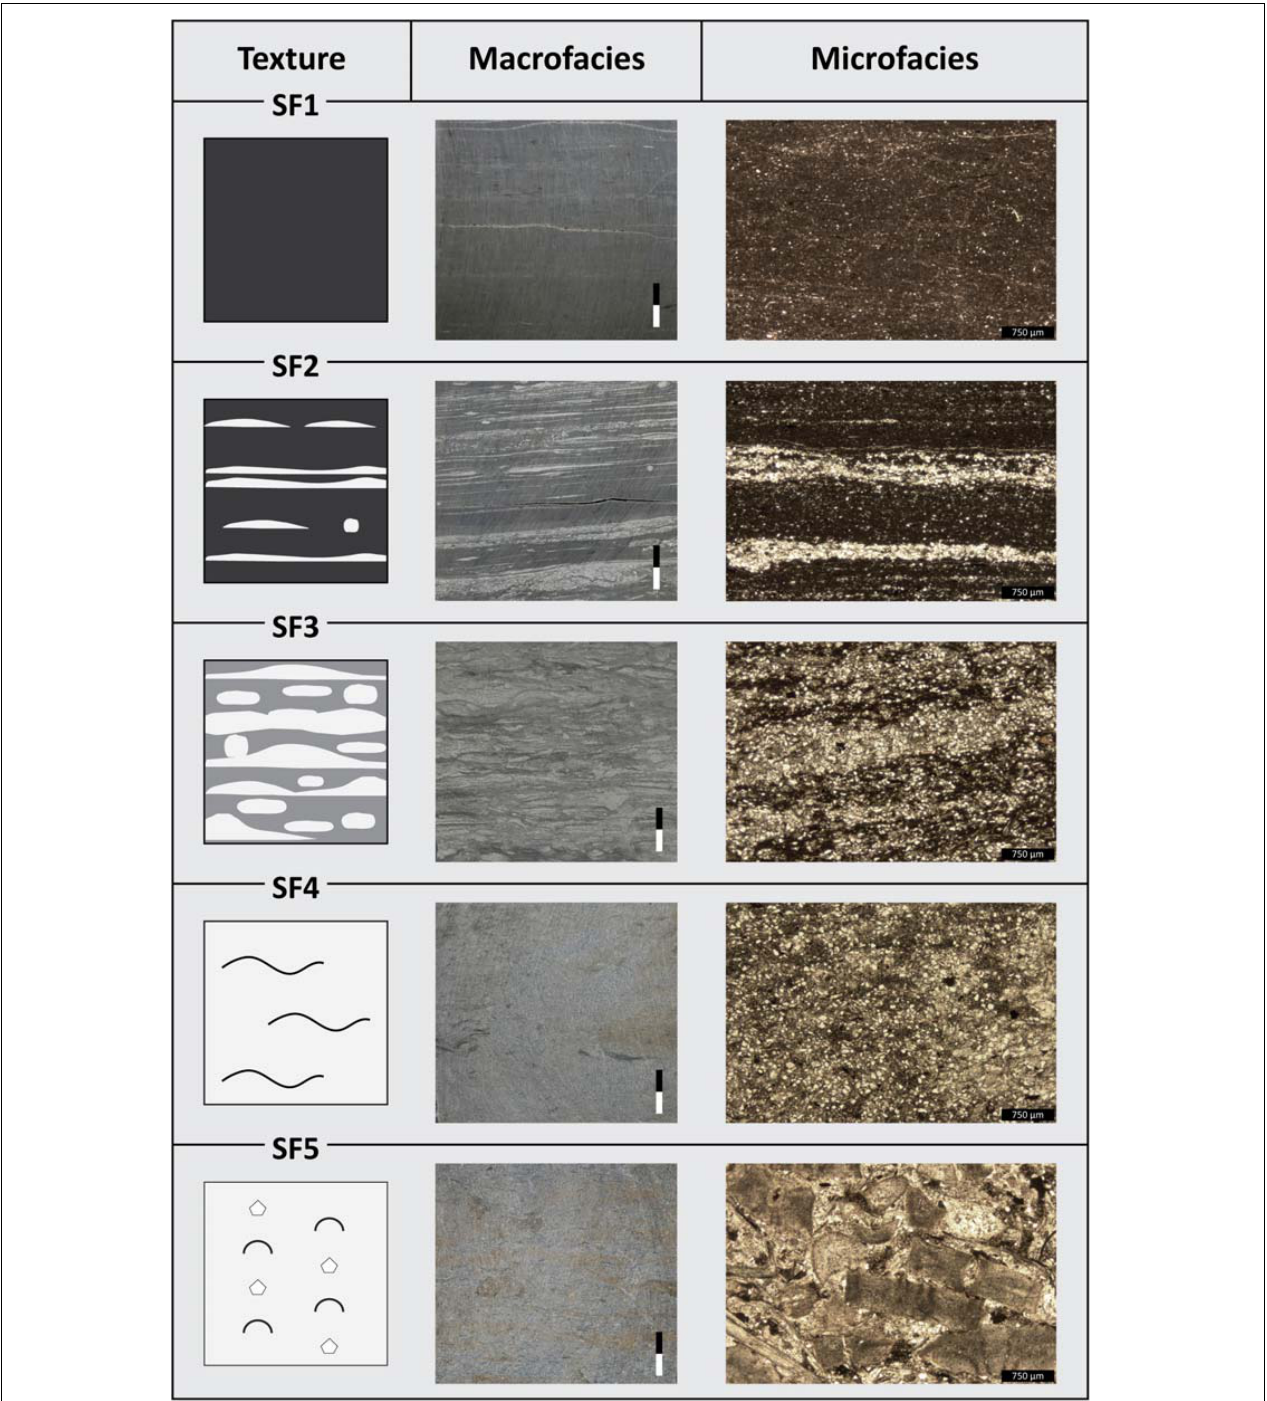
FIGURE 2 | Symbolized texture and typical macro- and microfacies for each subfacies type. SF1 shows a homogeneous, argillaceous “matrix.” Few dispersed, coarser silt grains occur. SF2 shows an argillaceous “matrix” with lenticular bedding. Thickness, length and origin of “lenses” vary; the “matrix” remains the dominant part. SF3 shows a coarser, argillaceous-siliceous “matrix” with non-regular “lenses.” The “lenses” are disturbed, rendering the distinction between “lenses” and “matrix” diffuse. SF4 shows a poorly sorted texture, dominated by silt- to sand-sized components, including quartz grains and bioclasts. Few argillaceous flasers may occur. SF5 resembles SF4, but displays a brighter aspect due to the high content of coarser (up to 2-mm-thick) bioclastic debris. Texture symbols: dark-gray, argillaceous; medium-gray, mixed, argillaceous-siliceous; light-gray, siliceous-calcareous; wavy line (SF4), occasional argillaceous flaser; pentagon (SF5), echinoderm fragment; semicircle (SF5), mollusk shell fragment. Thin sections were photographed in plane-polarized light at × 25 magnification. Scale bar for macrofacies = 2 cm; for microfacies = 750 µ m.